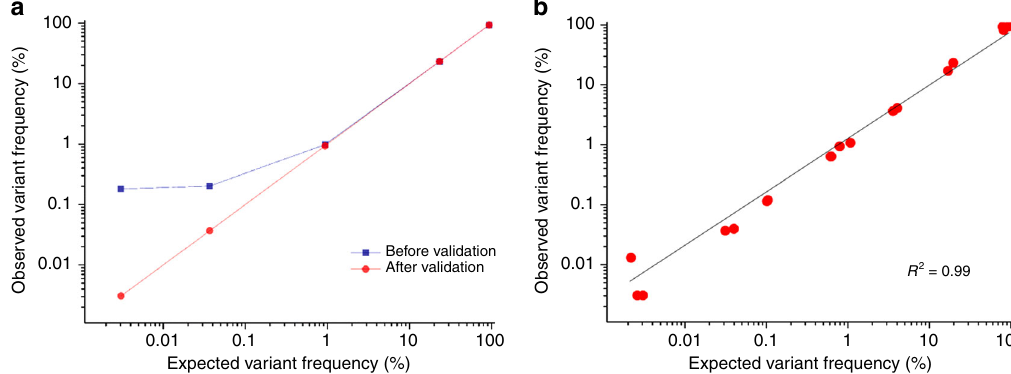
Fig. 3 The sensitivity of the barcode-free NGS error validation. a Barcode-free NGS error validation for detecting spike-in DNA sample varying amounts from 95.6% to 0.002%. Unexpected variants in raw NGS data (Supplementary Figure 3) were veri fi ed as NGS error. Accordingly, the R 2 values can be calculated using the observed variant frequency (VF) data and expected VF data. With the raw NGS result without NGS error validation, the R 2 value was 0.77 at below VF 1%. However, the R 2 value was 0.96 after the barcode-free NGS error validation. b Unexpected variants were validated as miscalled bases and fi nally, true variants were distinguished showing varying frequencies, from 95.6% to 0.002%, in four repeats ( R 2 = 0.99, n = 19). Source data